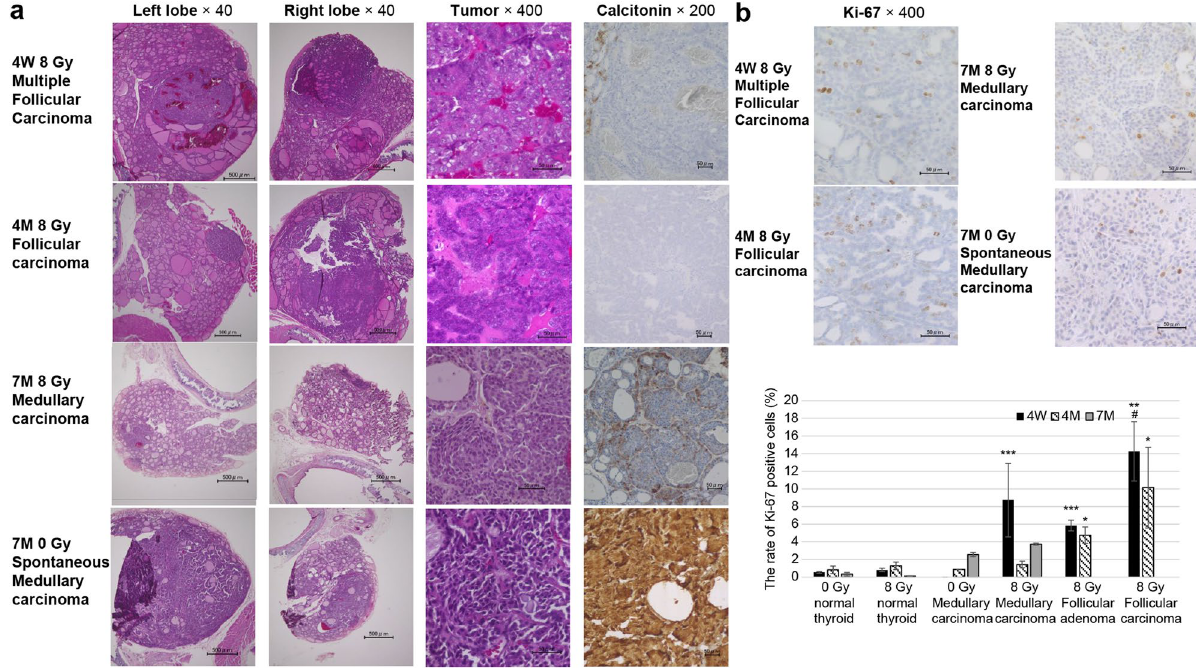
Figure 4. Incidence of radiation-induced and spontaneous thyroid tumors in 4W, 4M, and 7M rats. ( a ) H&E and calcitonin staining of radiation-induced follicular carcinoma in irradiated 4W and 4M rats, medullary carcinoma in irradiated 7M rats, and spontaneous medullary carcinoma in nonirradiated 7M rats. ( b ) Ki-67 staining of radiation-induced follicular carcinoma in irradiated 4W and 4M rats, medullary carcinoma in irradiated 7M rats, and spontaneous medullary carcinoma in nonirradiated 7M rats. Data are expressed as mean ± SEM of 0 Gy to normal in 4W (n = 15), 4M (n = 8), and 7M (n = 4) rats; 0 Gy to C-cell carcinoma in 4W (n = 1) and 4M (n = 2) rats; 8 Gy to normal in 4W (n = 5), 4M (n = 4), and 7M (n = 3) rats; 8 Gy to C-cell adenoma in 4W (n = 3) and 4M (n = 1) rats; C-cell carcinoma in 4W (n = 5), 4M (n = 2), and 7M (n = 2) rats; follicular adenoma in 4W (n = 8) and 4M (n = 3) rats; and follicular carcinoma in 4W (n = 3) and 4M (n = 3) rats. * p < 0.05, ** p < 0.01 and *** p < 0.001 vs. 0 Gy normal. # p < 0.05 vs. 8 Gy follicular adenoma.